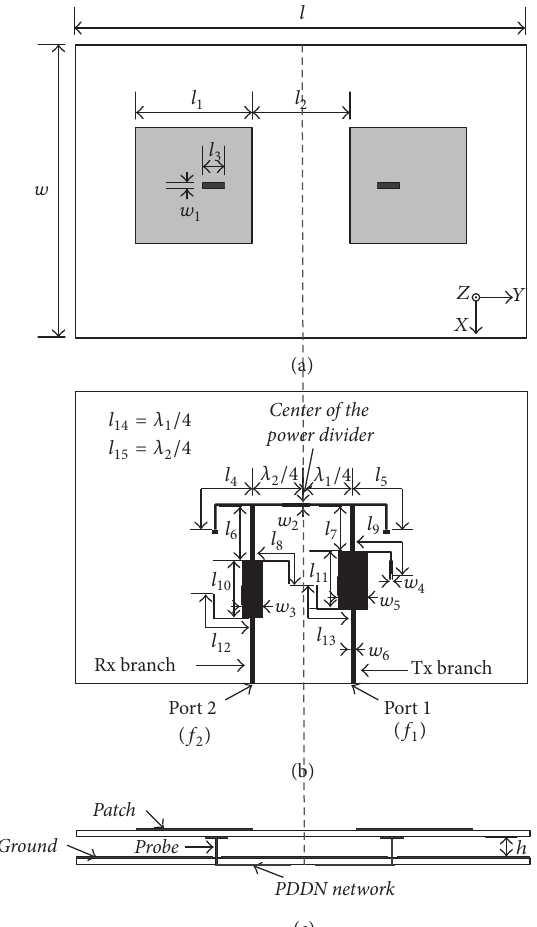
Figure 1: Geometry of the antenna array: (a) top view of the upper substrate, (b) the PDDN, (c) sectional drawing of the antenna array.